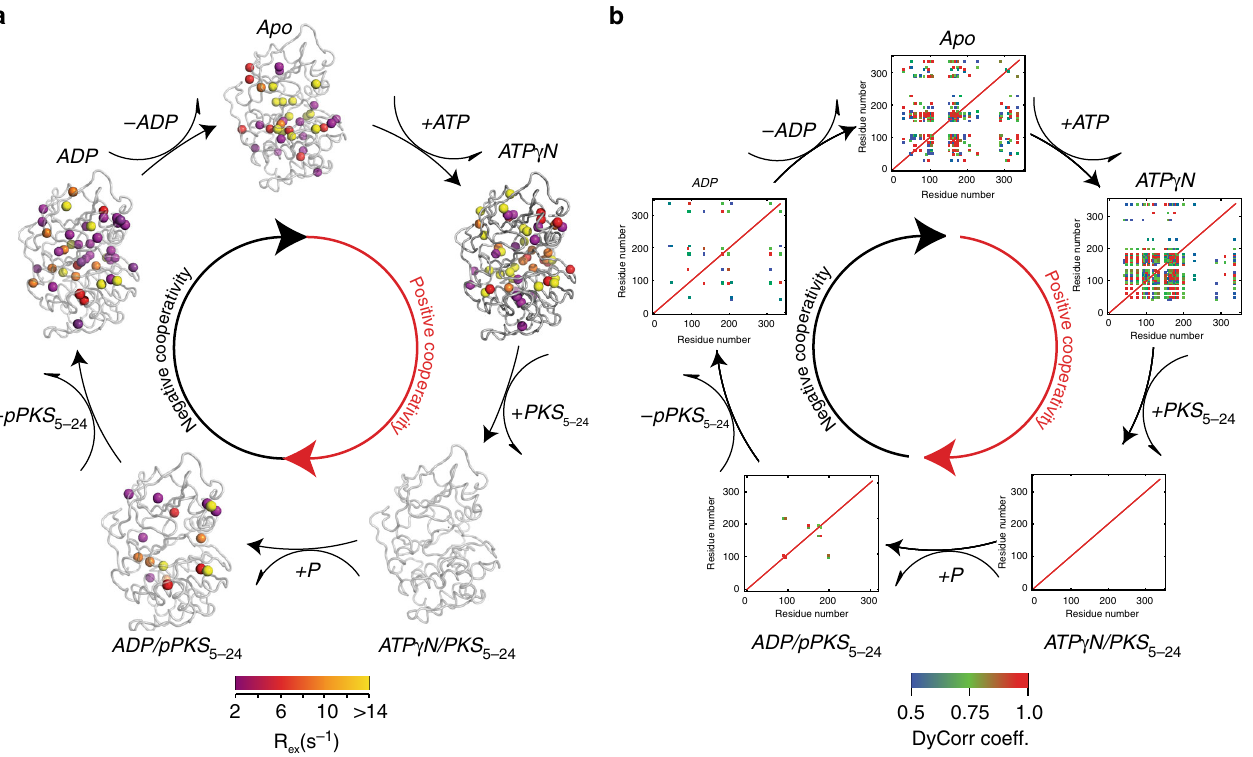
Fig. 5 Synchronous and asynchronous motions of PKA-C along reaction. a Conformational exchange rates obtained using methyl CPMG experiments mapped onto the X-ray crystal structures: apo (PDB code: 4NTS), binary complex (ATP γ N-bound, PDB code: 1BKX), ternary complex (ATP and PKS 5 – 24 , PDB code: 4DG0), ternary/exit complex (ADP and pPKS bound, PDB code: 4IAF), and binary (ADP-bound, PDB code: 4NTT). b DyCorr maps of the different states of the kinase, showing the synchronization of motion upon nucleotide binding and the asynchronous dynamics in the ternary exit complex and ADP